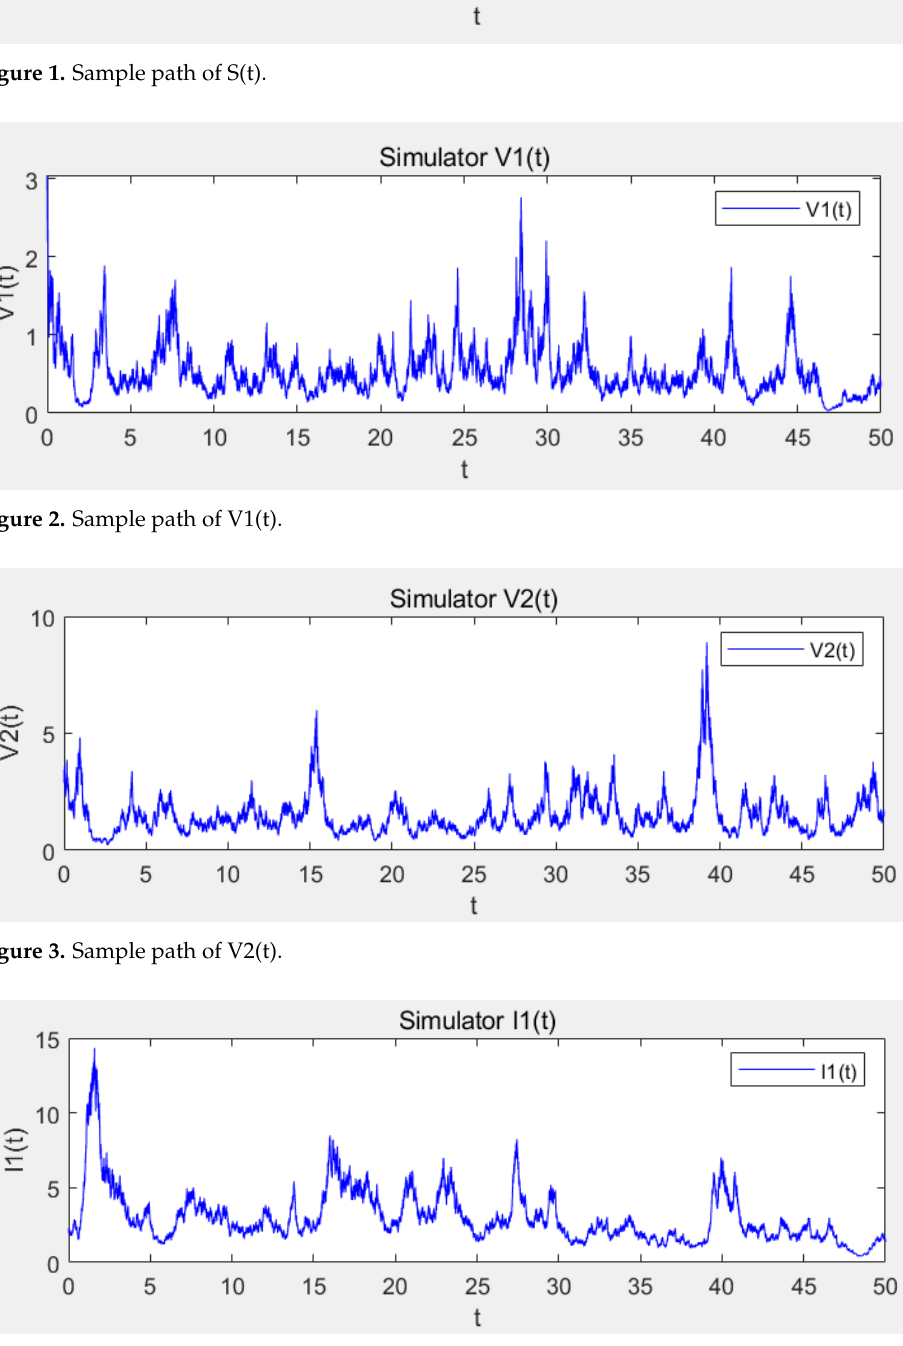
Figure 4. Sample path of